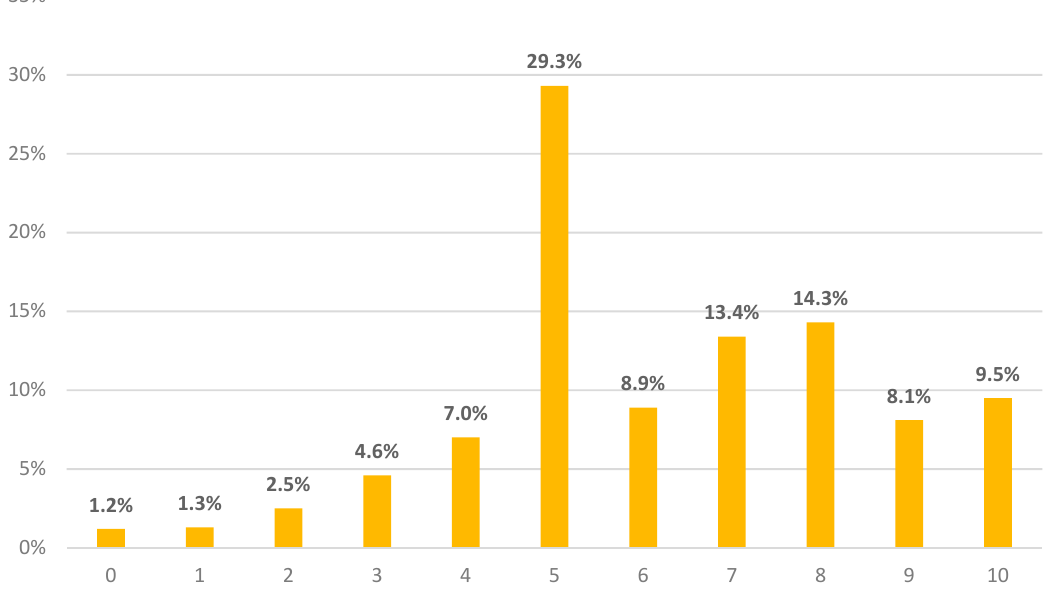
Figure 4. Self-assessment of the improvement in knowledge of remote-sensing data (RSD) as a result of participation in the ARSET program. Values indicate the percentage of respondents who selected each option. In the 11-point scale used, 0 = did not change, and 10 = improved a great deal ( N =